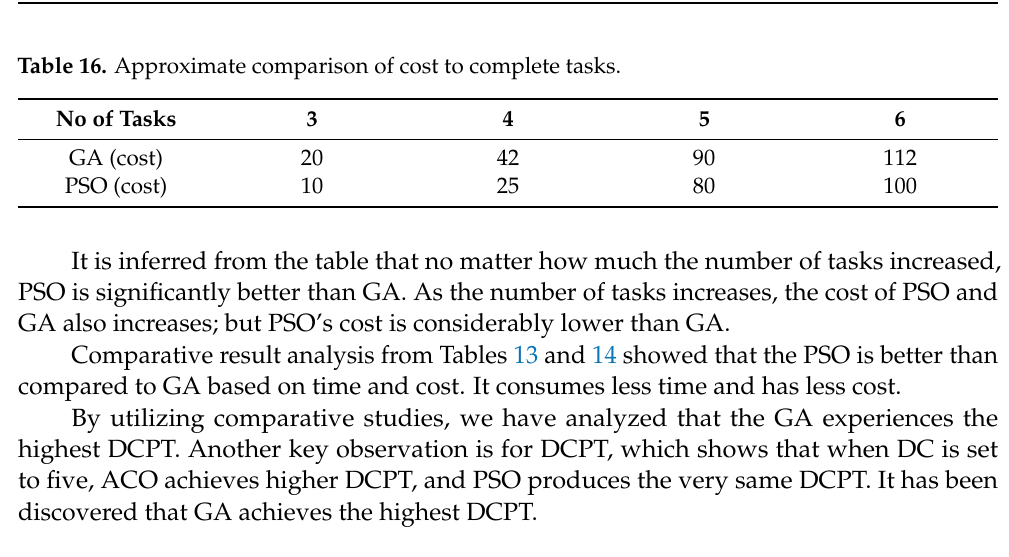
Table 15. Approximate comparison of time to complete tasks. No of Tasks 3 4 GA (time) PSO (time)